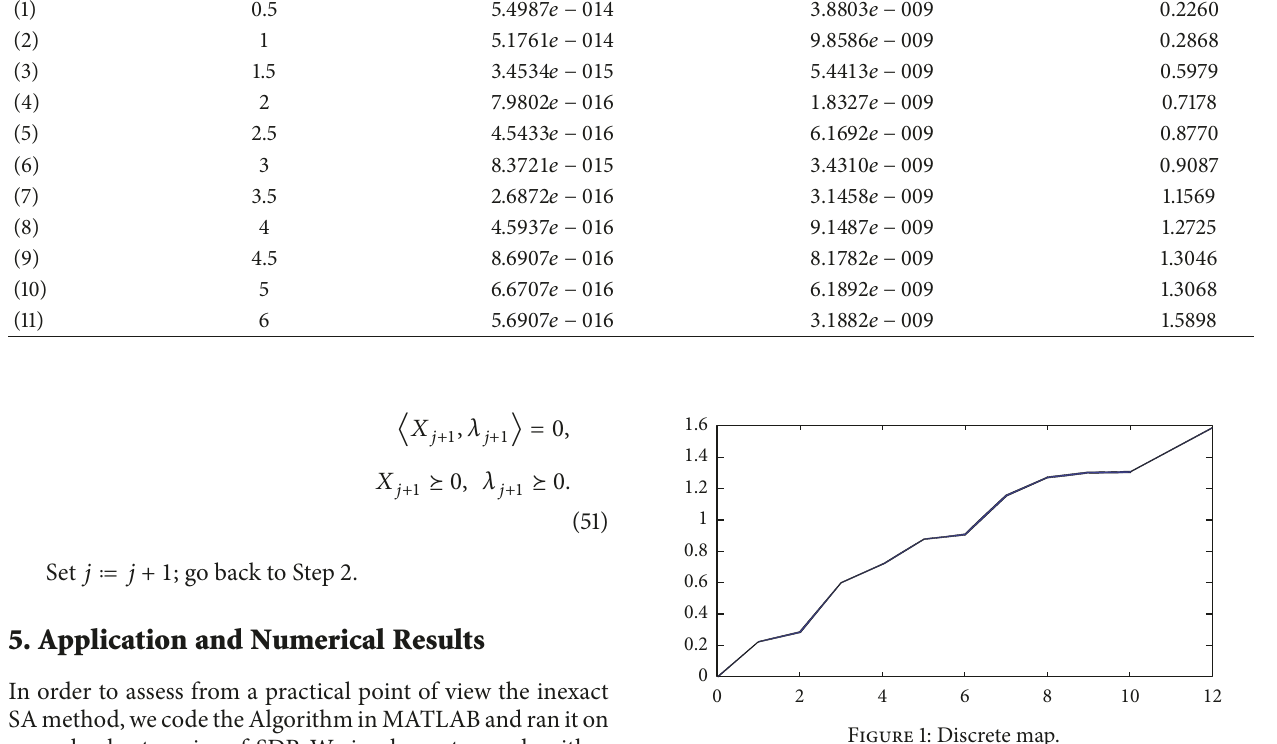
Figure 1: Discrete